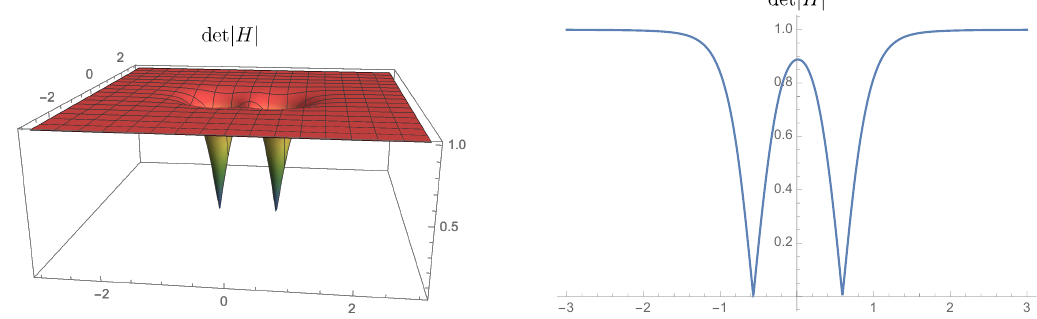
Figure 6 . Plots of det | H | of the vortex molecule solution in the U(1) a symmetric case. The right panel is the slice of the left 3D plot at y = 0 . The determinant has two zeros at ( x, y ) = ( ± 0 . 6 , 0) , indicating the positions of the two vortices. The model parameters are the same as those in figure 5.